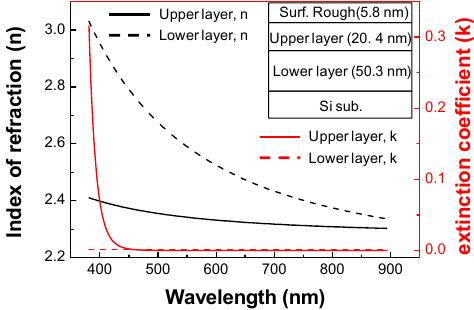
Figure 4. The extracted index of refraction ( n ) and extinction coefficient ( k ) of upper and lower layers as functions of wavelength (the inset shows the fitting model).